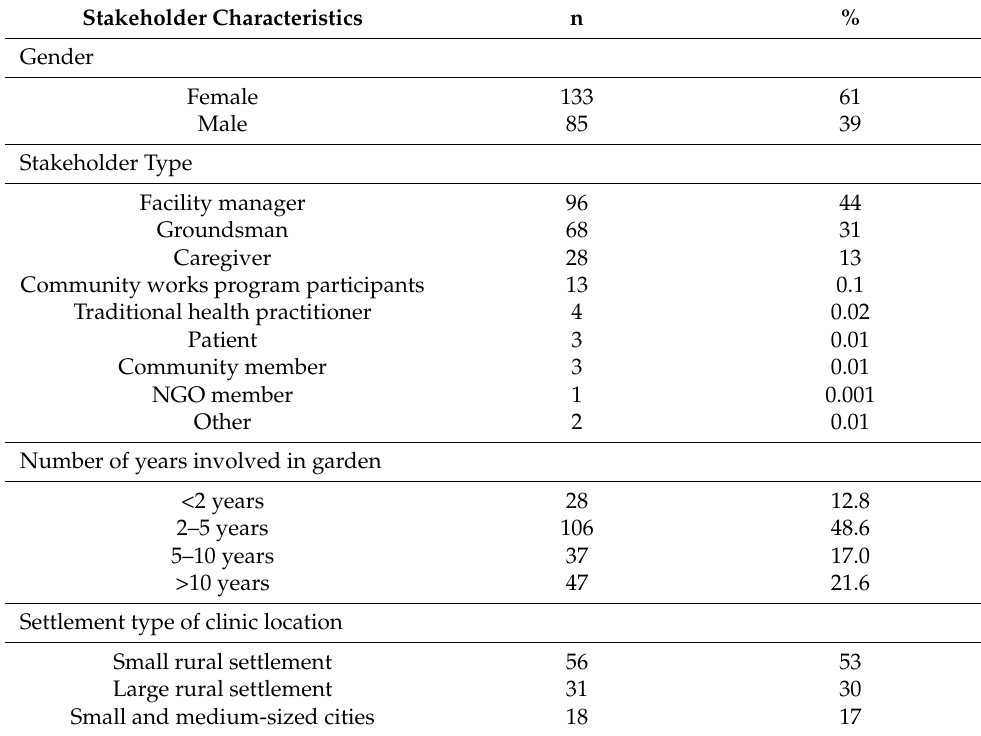
Table 2. Characteristics of respondents and clinics included in this